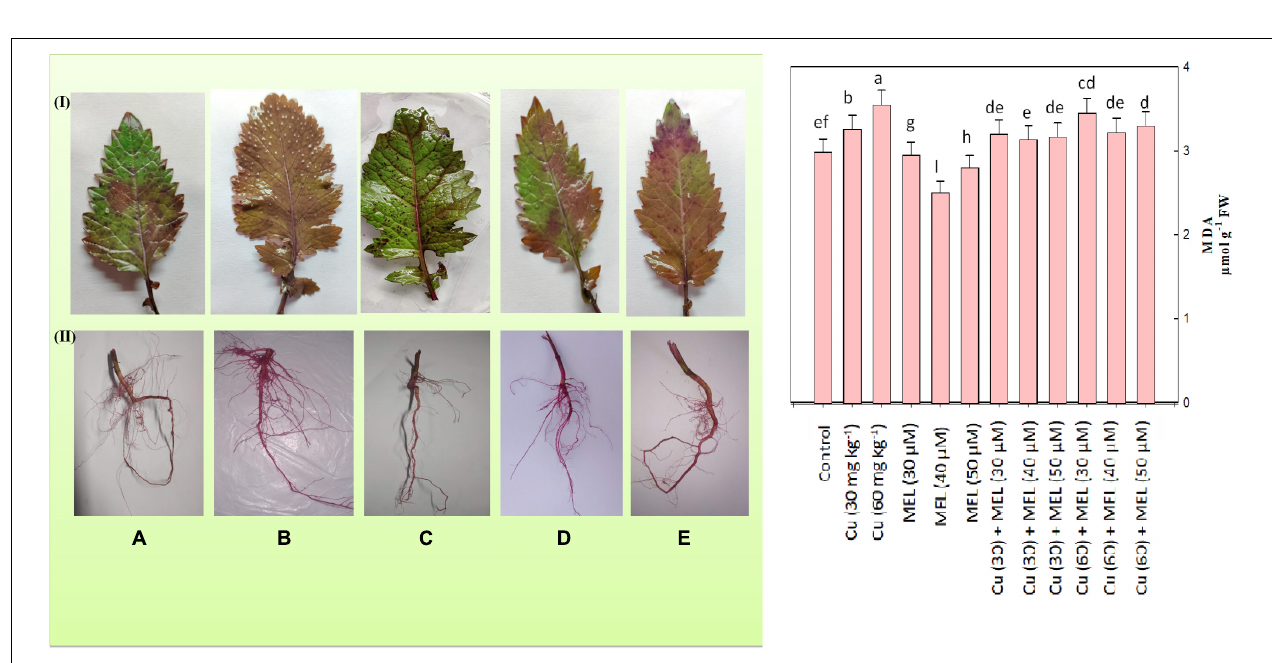
FIGURE 2 | (I) Superoxide anion content and histochemical localization of O 2 − in the leaves of 45-day-old B. juncea (L.) cv. Varuna raised with Cu and/or sprayed with MEL. (A) Control, (B) Cu 60 mg kg − 1 , (C) MEL 40 µ M, (D) Cu 30 + MEL (40 µ M), and (E) Cu 60 + MEL (40 µ M). Data show the mean ± standard error, and same letters indicate no significant difference at P < 0.05. (II) Hydrogen peroxide content and histochemical localization of H 2 O 2 in the leaves of 45-day-old B. juncea (L.) cv. Varuna raised with Cu and/or sprayed with MEL. (A) Control, (B) Cu 60 mg kg − 1 , (C) MEL µ M, (D) Cu 30 + MEL (40 µ M), and (E) Cu 60 + MEL (40 µ M). Data show the mean ± standard error, and same letters indicate no significant difference at P < 0.05. (III) Reactive oxygen species (ROS) localization in the roots of 45-day-old B. juncea (L.) cv. Varuna raised with Cu and/or sprayed with MEL. (A) Control, (B) Cu 60 mg kg − 1 , (C) MEL µ M, (D) Cu 30 + MEL (40 µ M), and (E) Cu 60 + MEL (40 µ M).